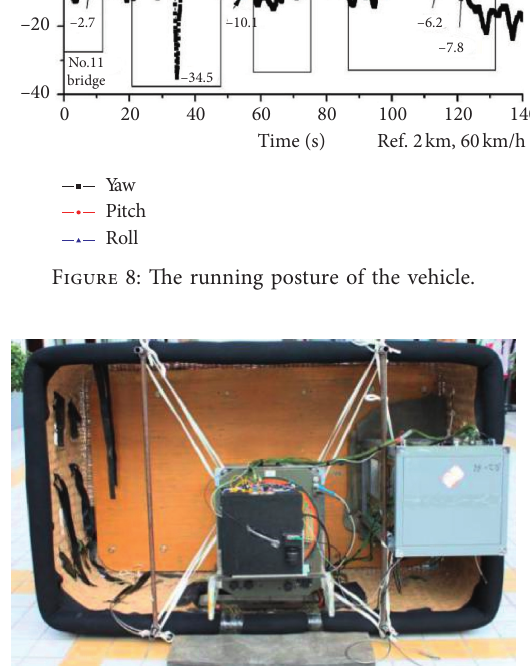
Figure 9: Hot-air balloon large hanging basket installation